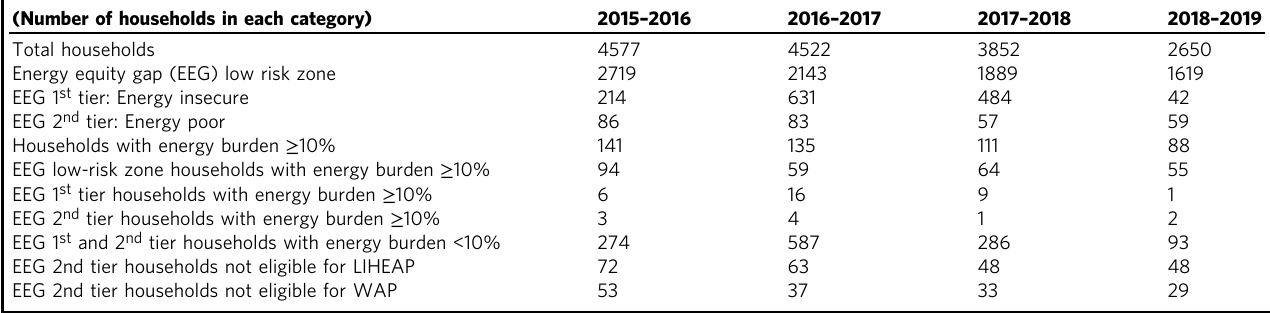
Table 2 Comparing the energy equity gap (EEG) and fi nancial-based energy assistance categories. (Number of households in each category)